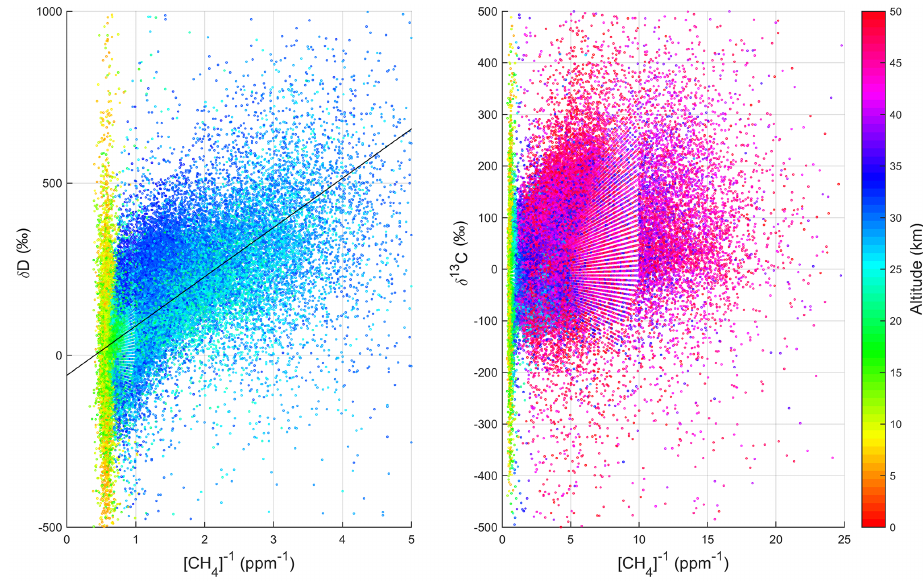
Figure 9. Keeling plots of ACE data for δ D (left) and δ 13 C (right). Each data point is color-coded by its measurement altitude. The streaks of data present in the right figure are artifacts; ACE measurements are retrieved to three significant figures, causing a sharp change in precision around 10ppm − 1 (e.g., 9.99ppm vs.